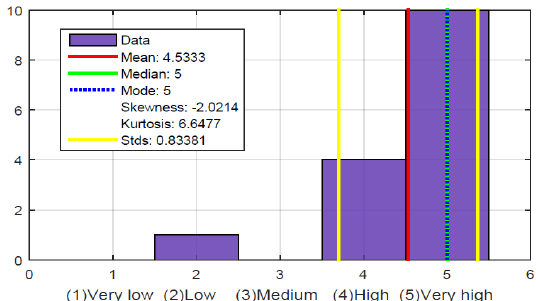
Figure 24. To what extent do you think the gadget is useful as an add-on for sports narration on TV?